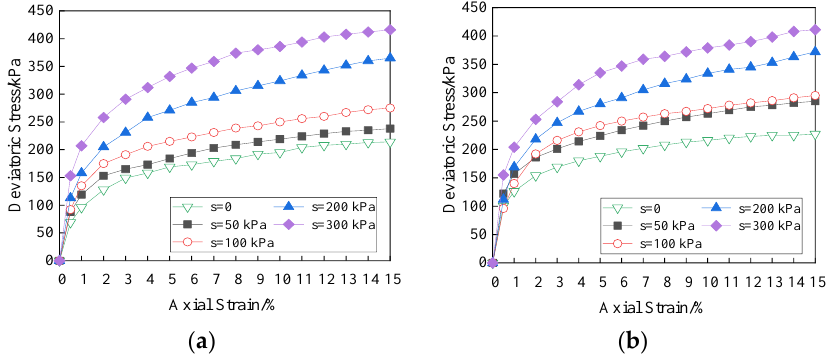
Figure 10. Effects of matric suction on stress vs. strain curves (Net confining pressure = 100 kPa). ( a ) Fiber length = 6 mm, ( b ) fiber length = 19